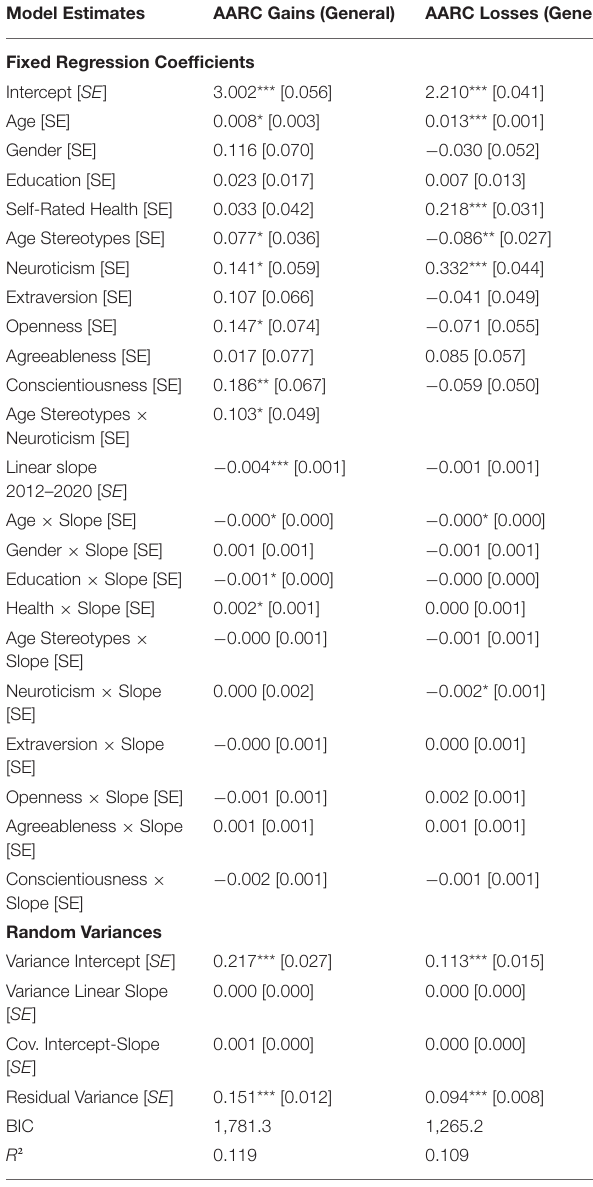
TABLE 4 | Longitudinal multilevel regression models: personality and age stereotypes as predictors of changes in AARC gains and losses. Model